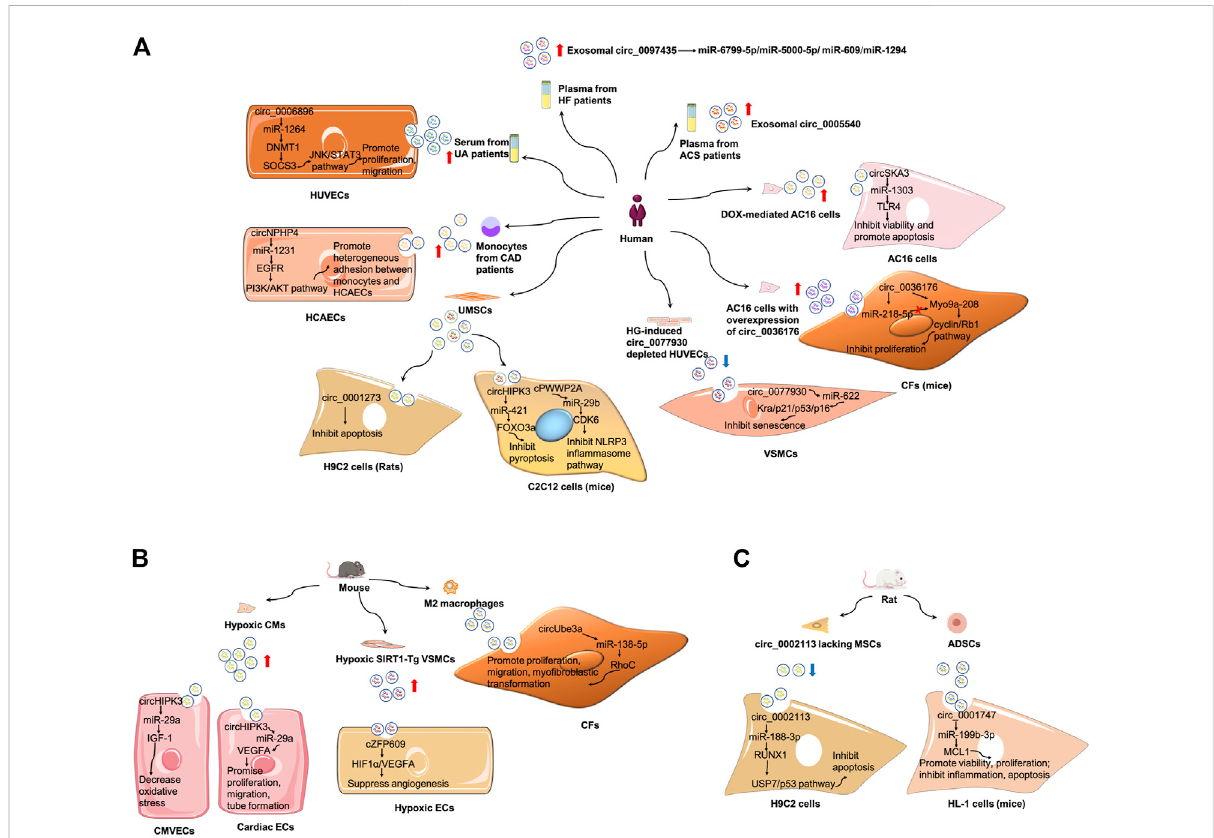
FIGURE 4 Mechanism ofexosomal circRNAs in CVDs. (A) Summaryof studies of exosomal circRNAs in human CVDs. (B) Summaryof studies ofexosomal circRNAs in mouse CVDs. (C) Summary of studies of exosomal circRNAs in rat CVDs. ADSCs, adipose-derived stem cells; CAD, coronary artery disease; CMVECs, cardiac microvascular endothelial cells; ECs, endothelial cells; HCAECs, human coronary artery endothelial cells; HG, hyperglycemia; HUVECs, human umbilical vein endothelial cells; MSCs, mesenchymal stem cells; UA, unstable/vulnerable plaque atherosclerosis; VSMCs, vascular smooth muscle